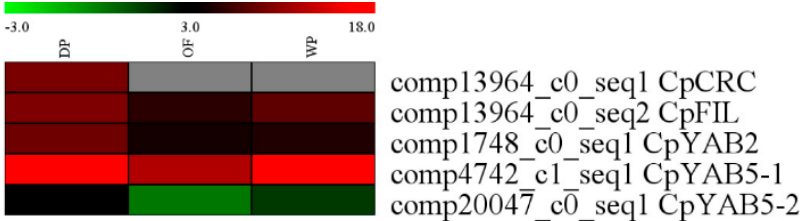
higher than that in OF and WP and the lowest in WP (Figure 6).